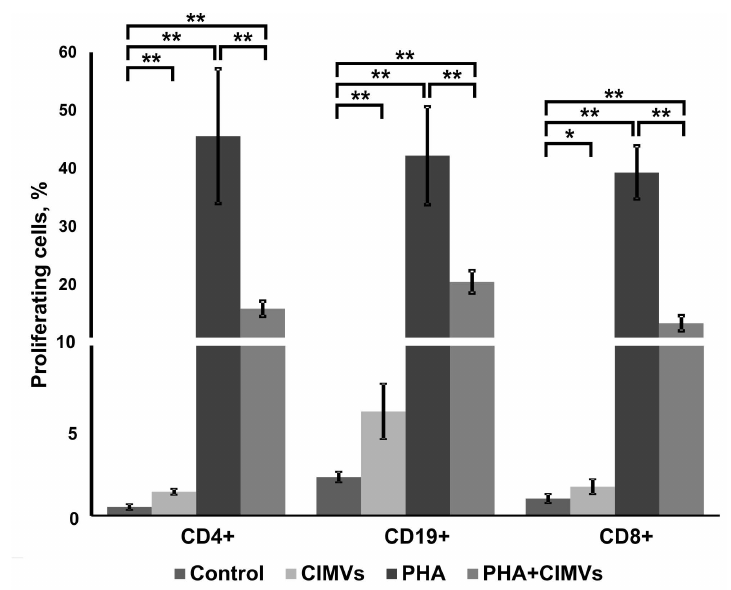
Figure 5. Analysis of the CIMVs-MSCs e ff ect on PHA-induced proliferation of T-cytotoxic (CD8 + ), T-helper (CD4 + ), and B-cells (CD19 + ). Lymphocytes were stained with CFDA SE, followed by incubation with CIMVs-MSCs for 24 h and treatment with PHA (10 µ g / mL). Immunostaining using anti-CD4, anti-CD19, and anti-CD8 monoclonal antibodies was done on the 3rd day after activation. The percent of proliferating cells was determined three days after PHA incubation using flow cytometer BD FACS Aria III (BD Bioscience, USA). Experiments were repeated three times. Data represent mean ± SD. (*) Level of significance p < 0.05; (**) level of significance p < 0.01.